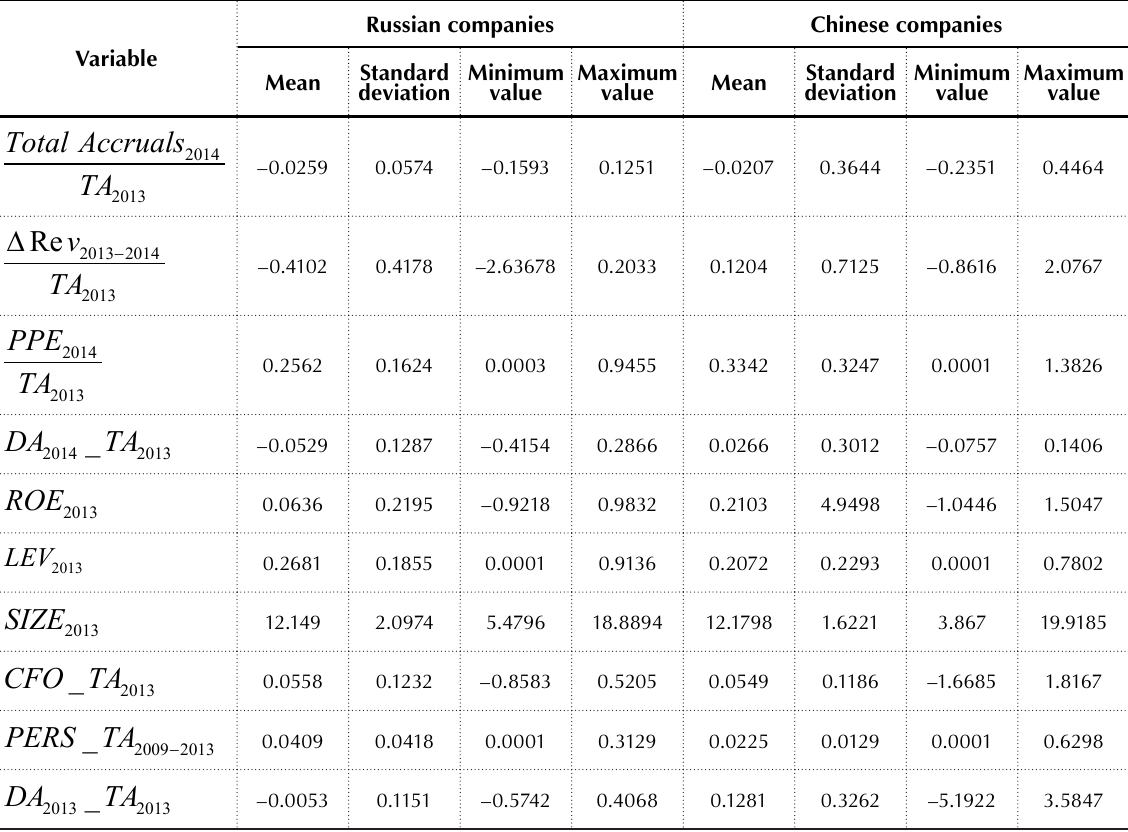
Table 3. The Jones model parameters estimation for 2014 (Russian and Chinese companies)